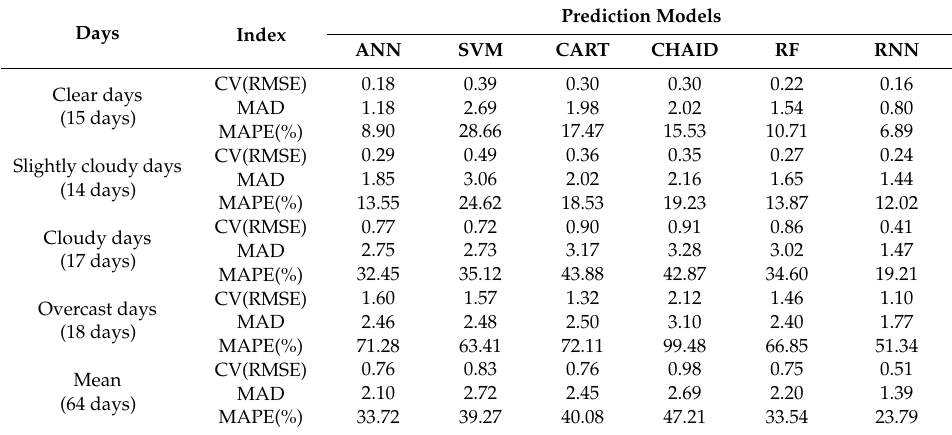
Figure 6. Hourly prediction results of the BIPV power output for typical sky conditions using the six machine-learning algorithms. Table 4. Comparison of model performance in terms of BIPV power output (64 days) for four types of sky